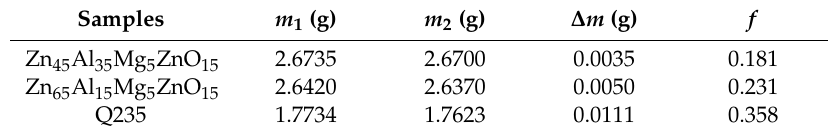
Table 3. Friction and wear data of Zn 65 Al 15 Mg 5 ZnO 15 , Zn 45 Al 35 Mg 5 ZnO 15 , and base steel Q235. Samples